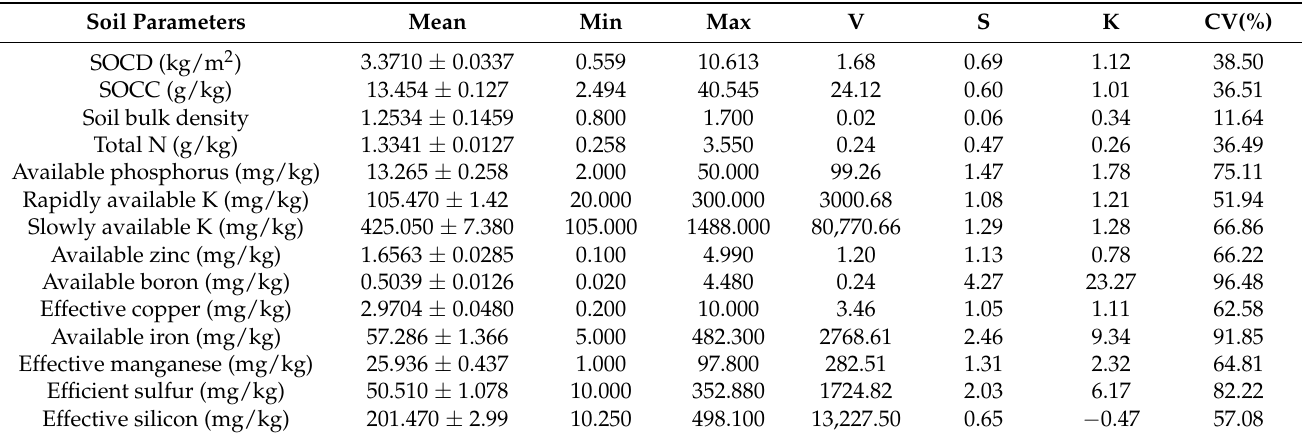
Table 2. Organic matter parameters and nutrient elements in the